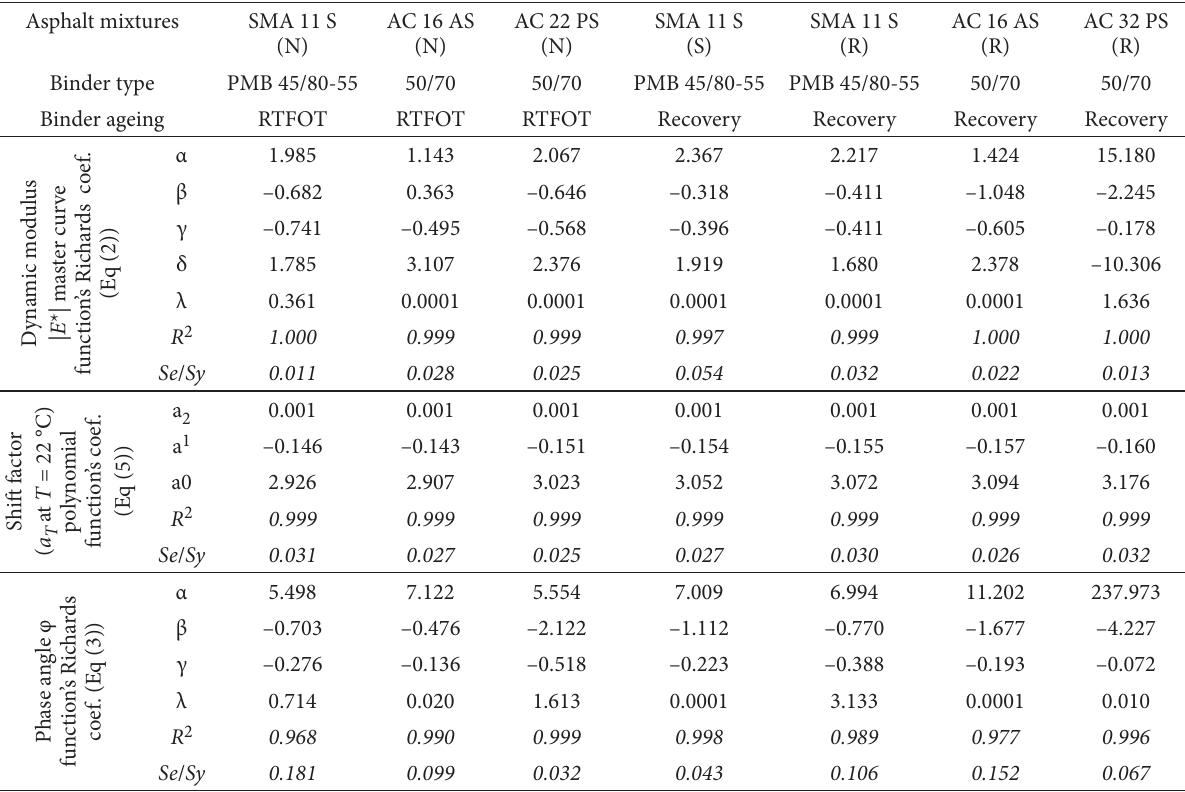
Table 2. The coefficients of master curve function of predicted dynamic modulus according Hirsh model Asphalt mixtures